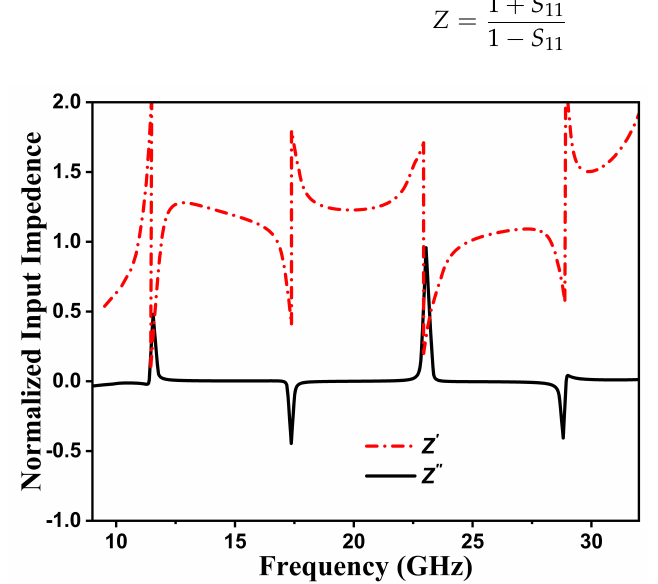
Figure 4. Normalized input impedance of the proposed